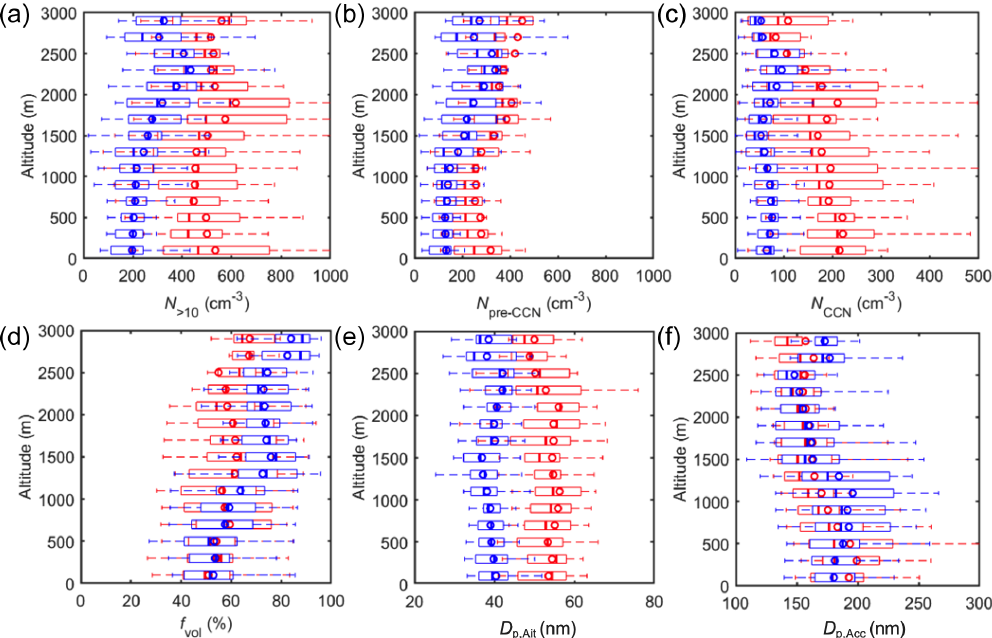
Figure 6. Vertical profiles showing the (a) concentration of particles larger than 10nm ( N > 10 ), (b) concentration of Aitken-mode aerosols or aerosols too small to form cloud droplets ( N pre-CCN ), (c) concentration of accumulation-mode aerosols or CCN ( N CCN ), (d) aerosol volatile fraction ( f vol ), (e) average size of Aitken-mode aerosol ( D p , Ait ), and (f) average size of accumulation-mode aerosol ( D p , Acc ) over the ENA site during the summer IOP (red) and winter IOP (blue). The concentrations are normalized to standard temperature and pressure (273.15K and 101.325kPa; STP). The line and circle markers represent the median and mean of the data, and the edges of the box indicate the 25th and 75th percentiles, respectively.